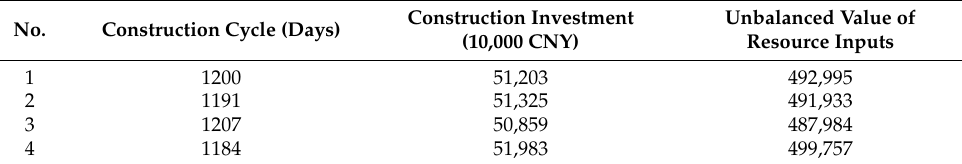
Table 4. Pareto solution set with priority of guaranteeing construction period.